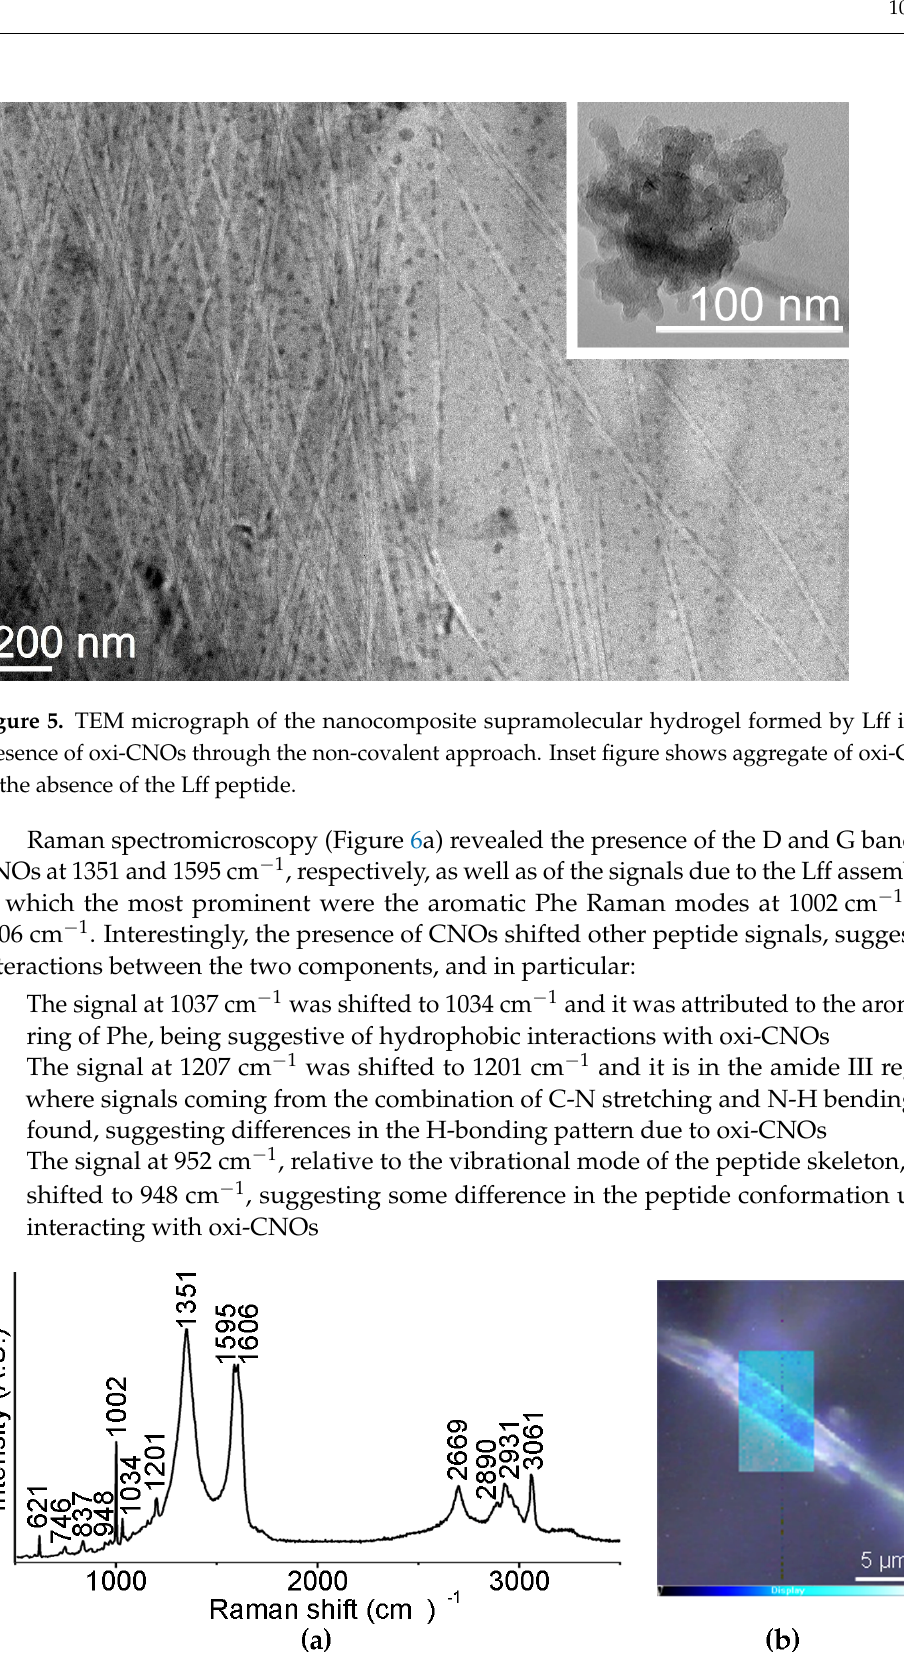
10 of 19 Figure 4. Photographs of ( a ) oxi ‐ CNOs without (left) and with (right) the self ‐ assembling tripeptide Lff in alkaline (pH 11.8) sodium phosphate precursor solution after 4 h post sonication (15 min) to prepare gels with 1.0 mg/mL oxi ‐ CNOs, and ( b ) nanocomposite supramolecular hydrogels with 2.5 mg/mL of Lff and increasing loadings of oxi ‐ CNOs (0.5, 1.0 and 2.0 mg/mL) at pH 7.4. Transmission electron microscopy (TEM) imaging revealed a network of highly ho ‐ mogeneous fibrils of 21 ± 2 nm ( n = 50) diameter that interacted on their surface with in ‐ dividual CNOs that appeared to be well ‐ dispersed within the matrix (Figure 5). This result contrasts the TEM images of oxi ‐ CNOs without the peptide, which instead displayed large